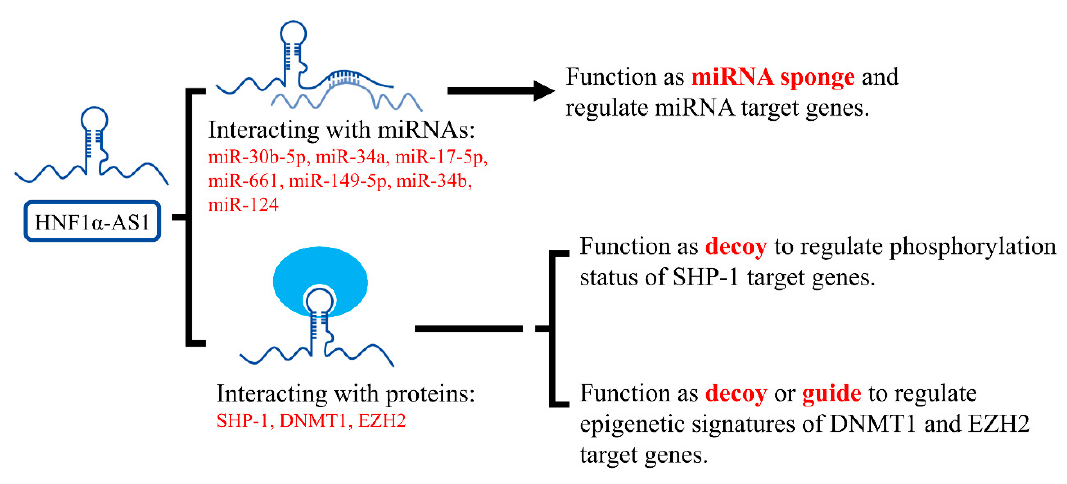
Figure 9. Mechanisms of HNF1 α -AS1 in the regulation of gene expression. HNF1 α -AS1 is currently found to interact with several miRNAs and proteins. By interacting with these molecules, HNF1 α - AS1 can function through mechanisms of a miRNA sponge, decoy, or guide to regulate gene